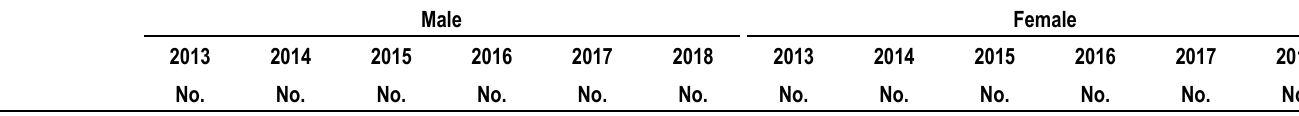
Table 8b. Diagnoses of HIV infection attributed to injection drug use, by selected characteristics, 2013–2018—United States and 6 dependent